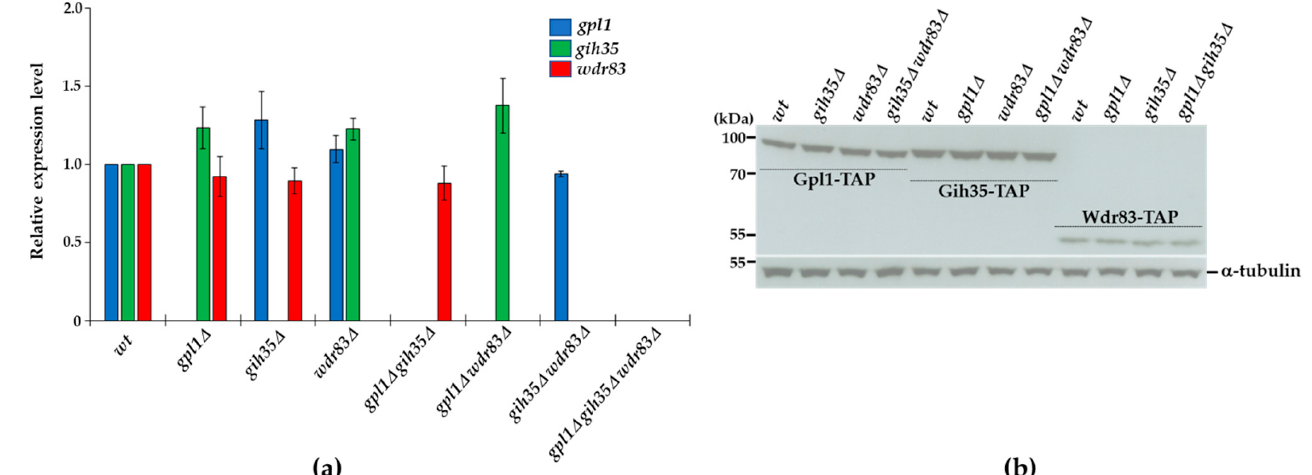
Figure 5. Analyses of gene expression and protein levels of components of the Gpl1-Gih35-Wdr83 complex: ( a ) RNA was isolated from wild-type ( wt ) cells or indicated deletion mutants in the exponential phase (OD 595 = 0.5–0.6), and gene expression was analyzed using RT-qPCR. The data represent transcript levels relative to wild-type cells after normalization to actin. The plotted values are the mean of three independent biological replicates ± SEM ( b ) Wild-type cells or deletion mutants expressing Gpl1-TAP (85.19 kDa), Gih35-TAP (97.46 kDa) and Wdr83-TAP (57.38 kDa) were grown in YE + 5S and harvested around OD 595 = 0.8. Extracted proteins were analyzed by SDS-PAGE and Western blotting using anti-tubulin and PAP antibodies. Tubulin (51.15 kDa) was used as a loading control. Full original images of Western blots are shown in Figure S2.